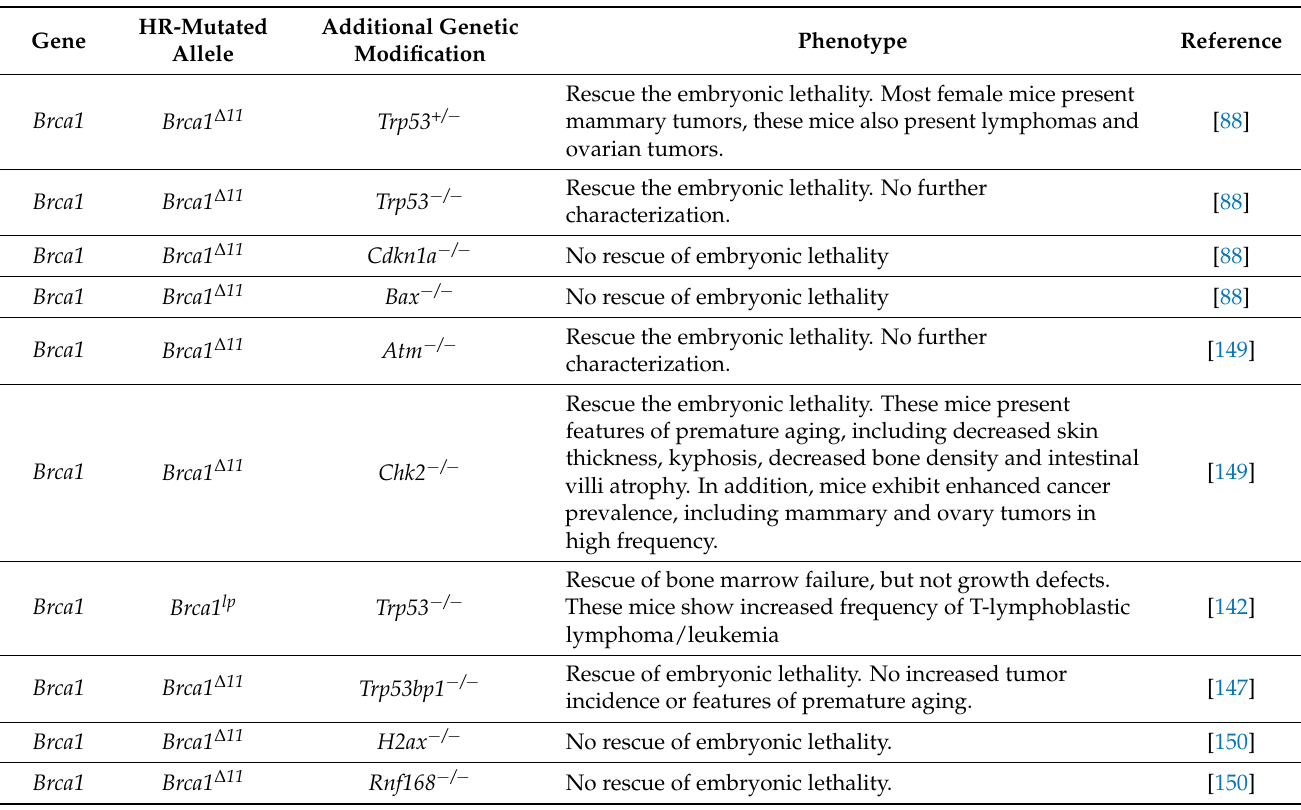
Table 4. Mouse models of genetic inactivation of HR genes with other DNA repair and DNA damage response genes. Phenotype: when the mutant allele is in homozygosis.